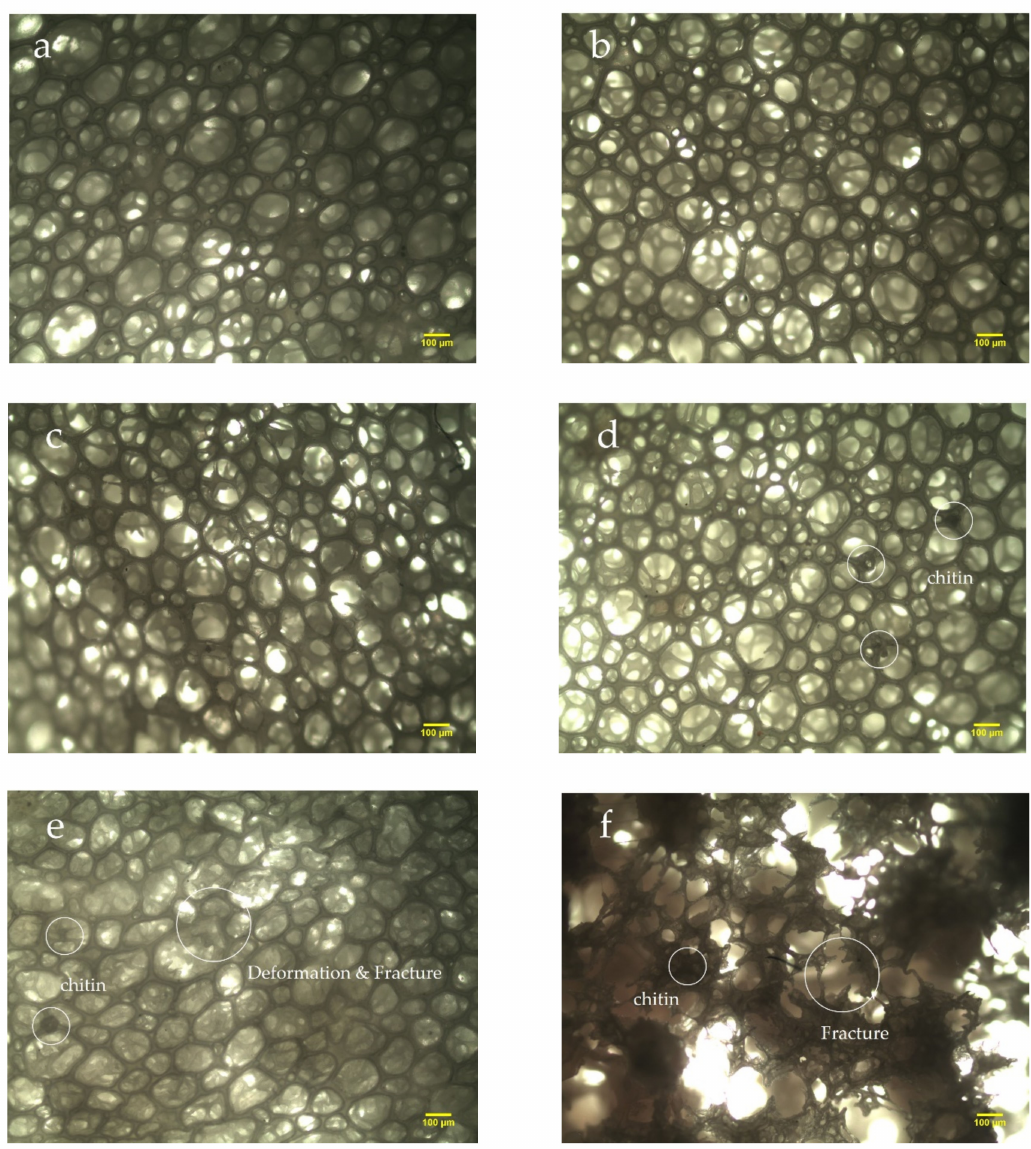
Figure 2. Micrographs of chitin–NRLF composites. ( a ) pure NRLF; ( b ) NRLF–1 phr chitin; ( c ) NRLF–2 phr chitin; ( d ) NRLF–3 phr chitin; ( e ) NRLF–4 phr chitin; ( f ) NRLF–5 phr